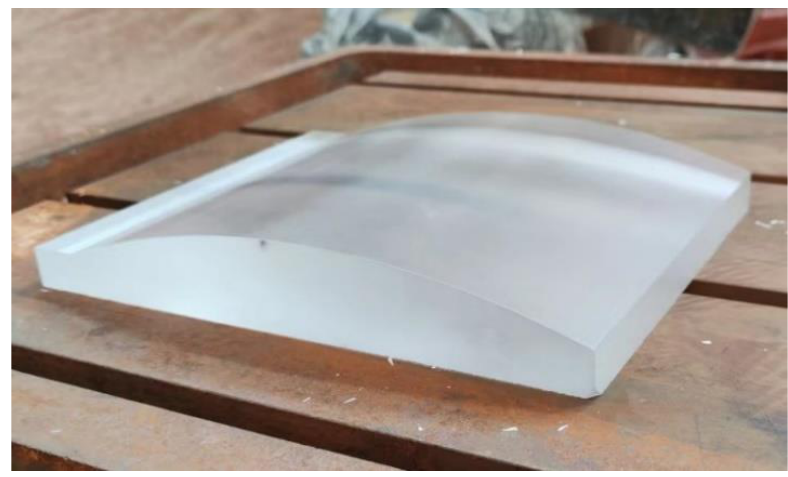
Figure 12. The actual effect diagram of the curved organic glass parts after milling.